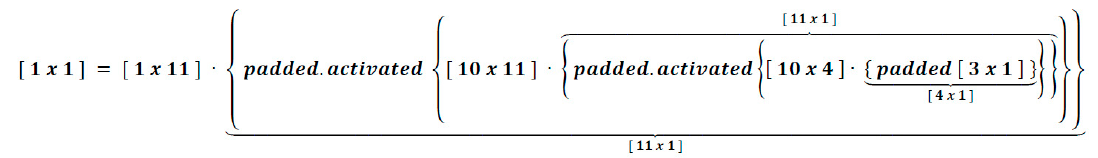
Figure 16. The compact ANN calculation modeled with matrix operations.